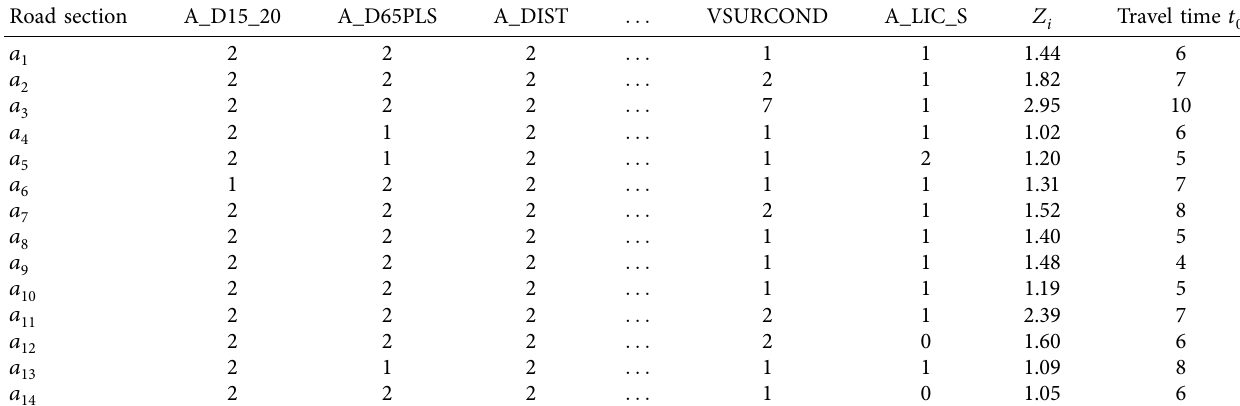
Table 4: Network parameters.